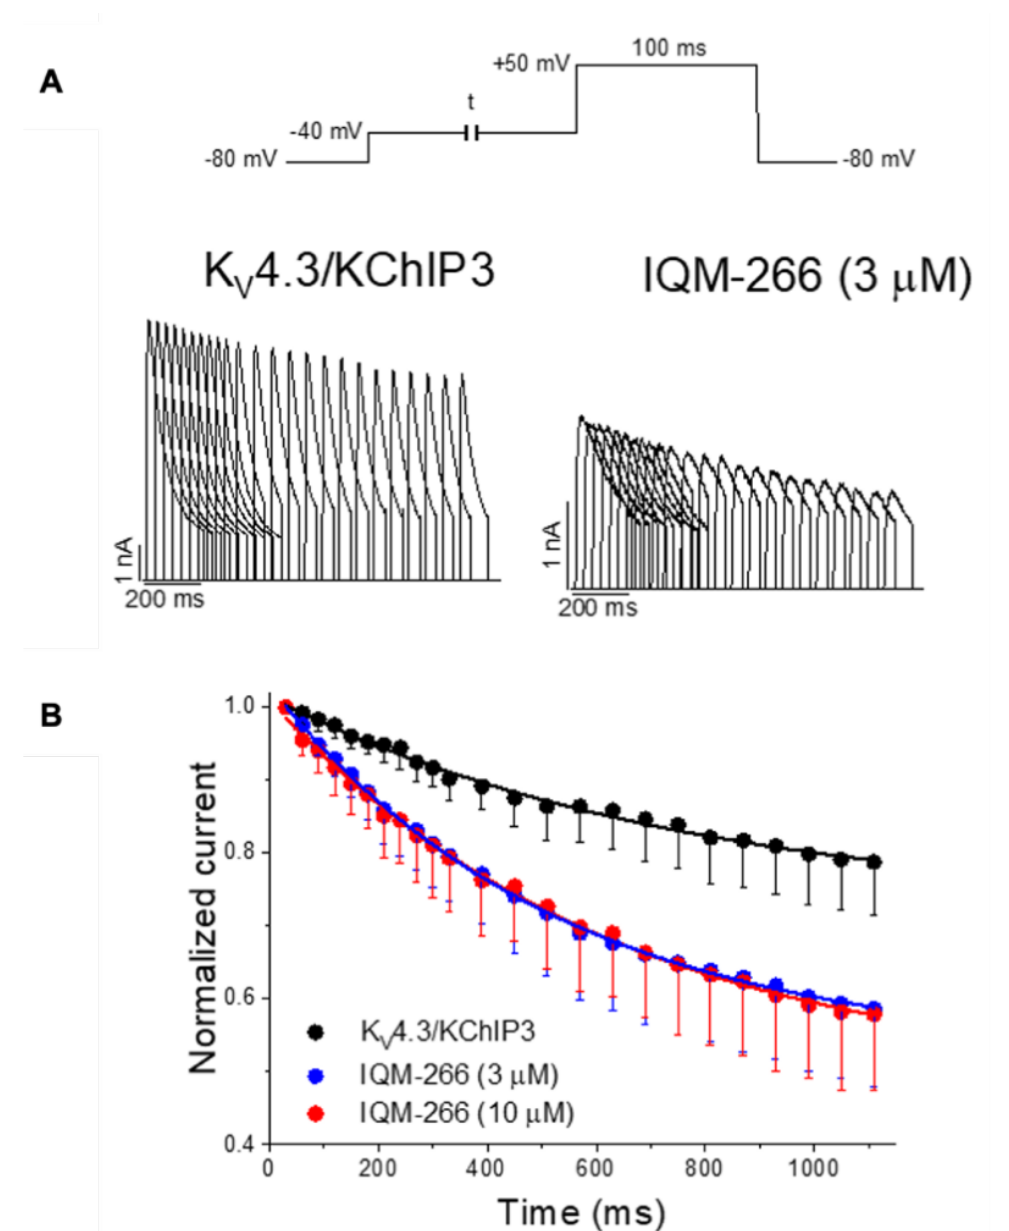
Figure 10. IQM-266 increases the closed-state inactivation of the K V 4.3/KChIP3 channels [70]. ( A ) Current records generated by K V 4.3/KChIP3 channels in the absence and in the presence of IQM-266 after applying the pulse protocols shown in the upper part of the figure. ( B ) Time course of closed-state inactivation of K V 4.3/KChIP3 channels at a membrane potential (−40 mV) at which this current inactivates, but does not conduct. Note how IQM-266 increases the closed-state inactivation.